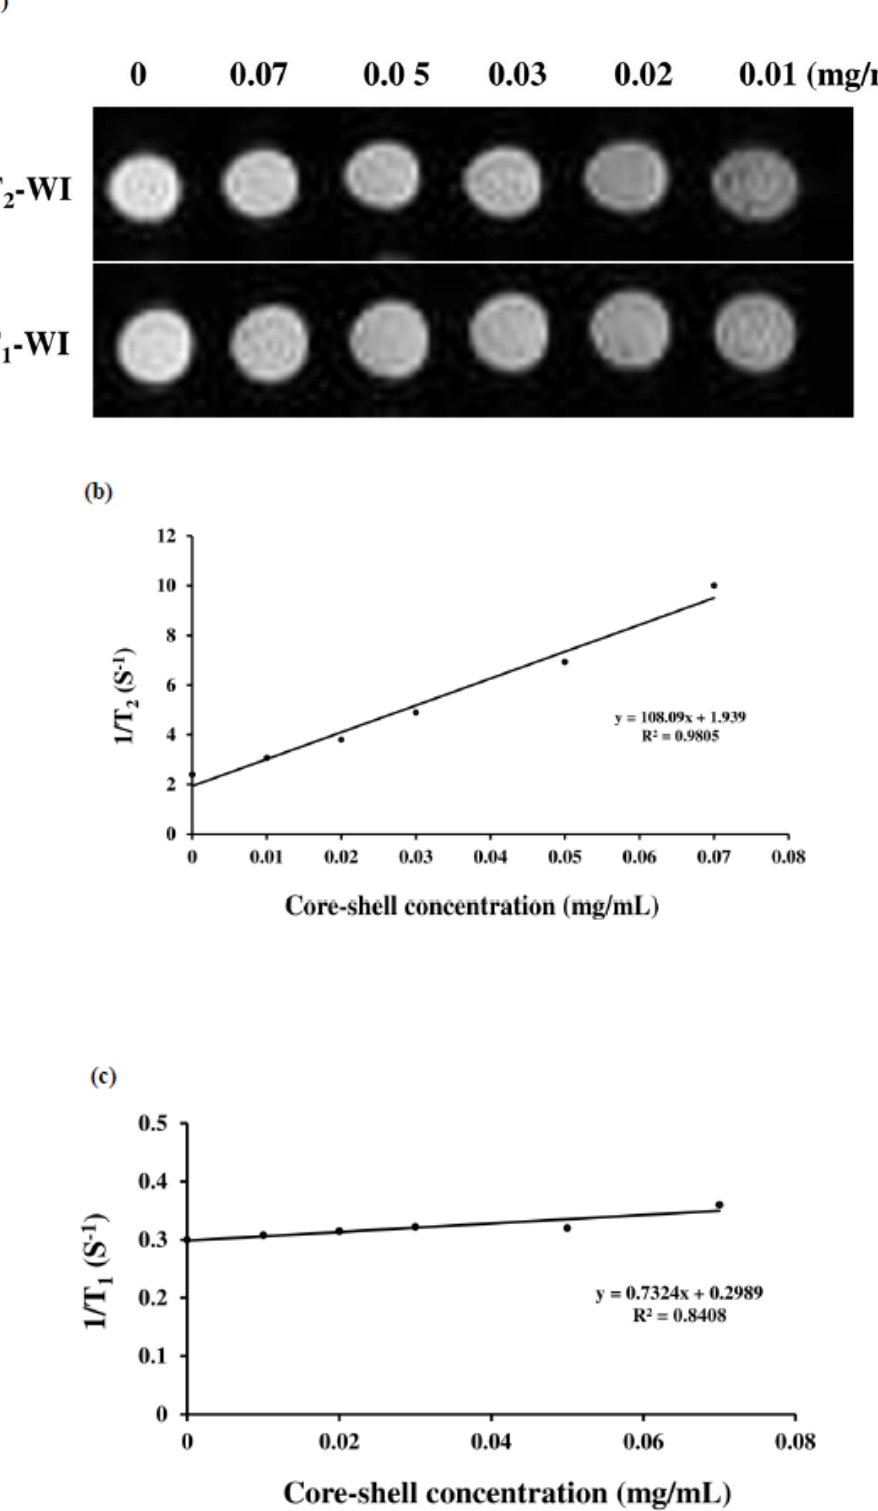
Figure 6. ( a ) T 1 and T 2 -weighted MR images at five di ff erent concentrations of nanocomposites. ( b ) The linear fitting of relaxation rates (1 / T 2 ) of versus nanocomposites concentrations. ( c ) The linear fitting of relaxation rates (1 / T 1 ) of versus nanocomposites concentrations. The relaxivity values of r 2 and r 1 were obtained from the